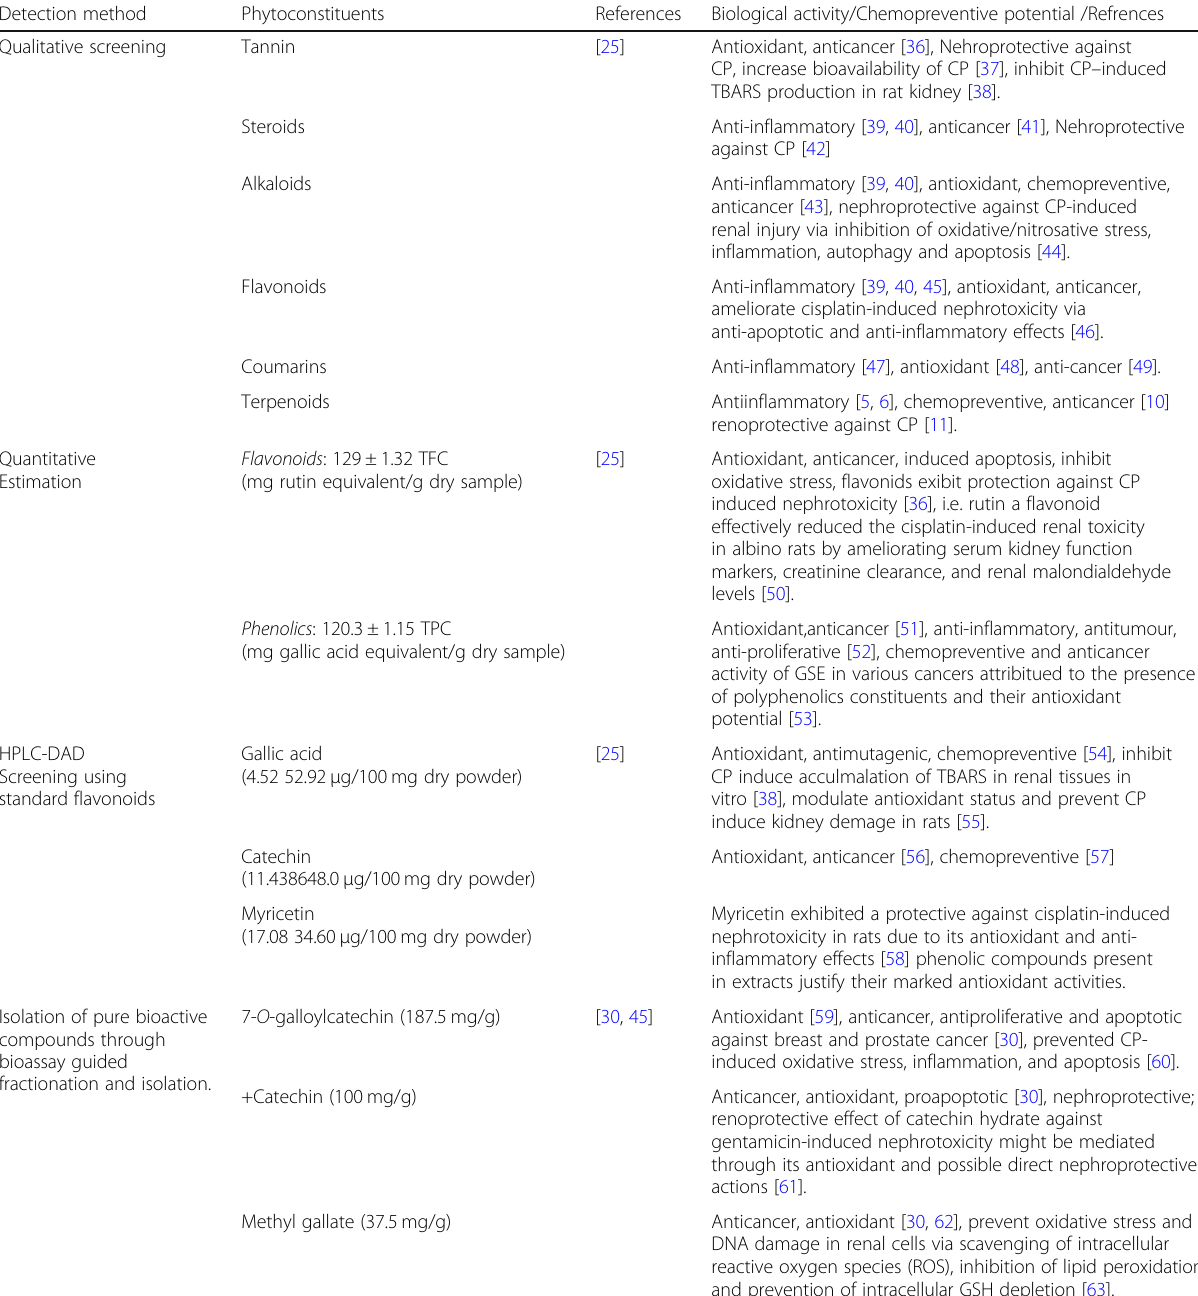
Table 1 Phytochemical composition of Acacia hydaspica ethyl acetate extract (AHE) Detection